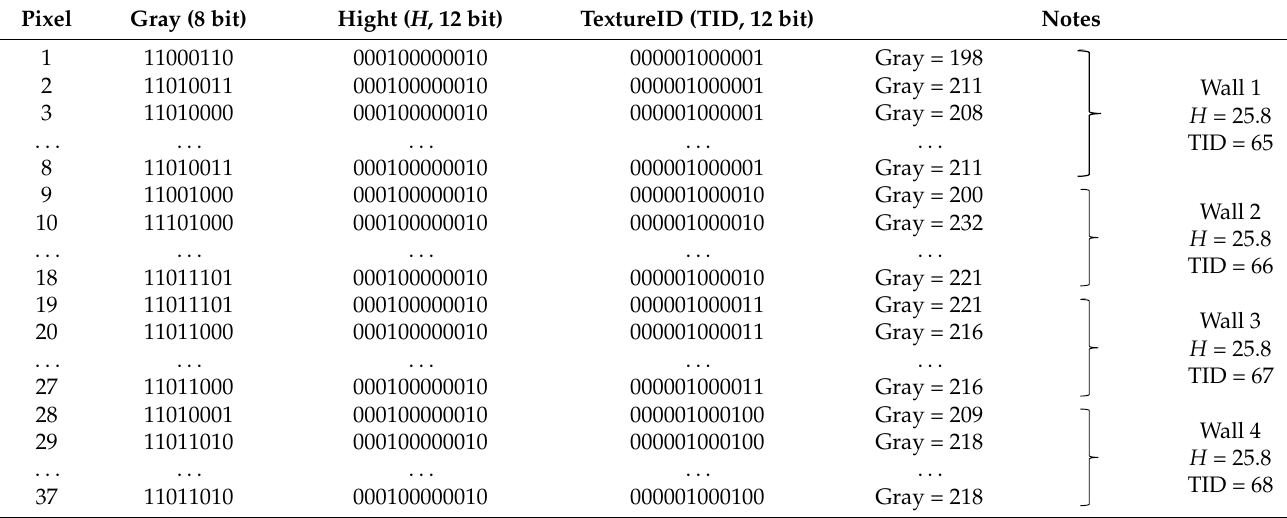
Table 4. The building wall texture index in Figure 7a. WallID Table 5. The building wall texture index in Figure 7b. WallID